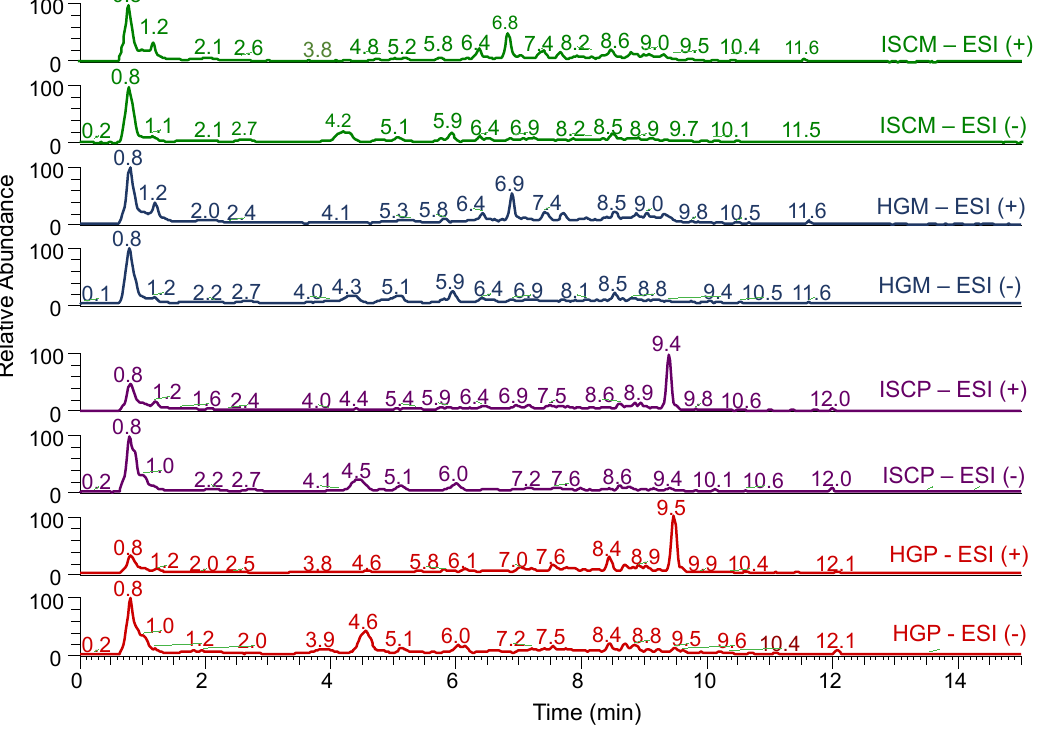
Figure 2. Typical LC-HRMS chromatograms of fermented aqueous extracts of V. album from the two host trees ( M. domestica and P. sylvestris ) and manufacturing processes (APVAE and VAE) in positive (ESI + ) and negative (ESI-) electrospray ionization modes. Abbreviations: ISCM: M. domestica / APVAE, HGM: M. domestica / VAE, ISCP: P. sylvestris / APVAE; HGP: P. sylvestris / VAE.